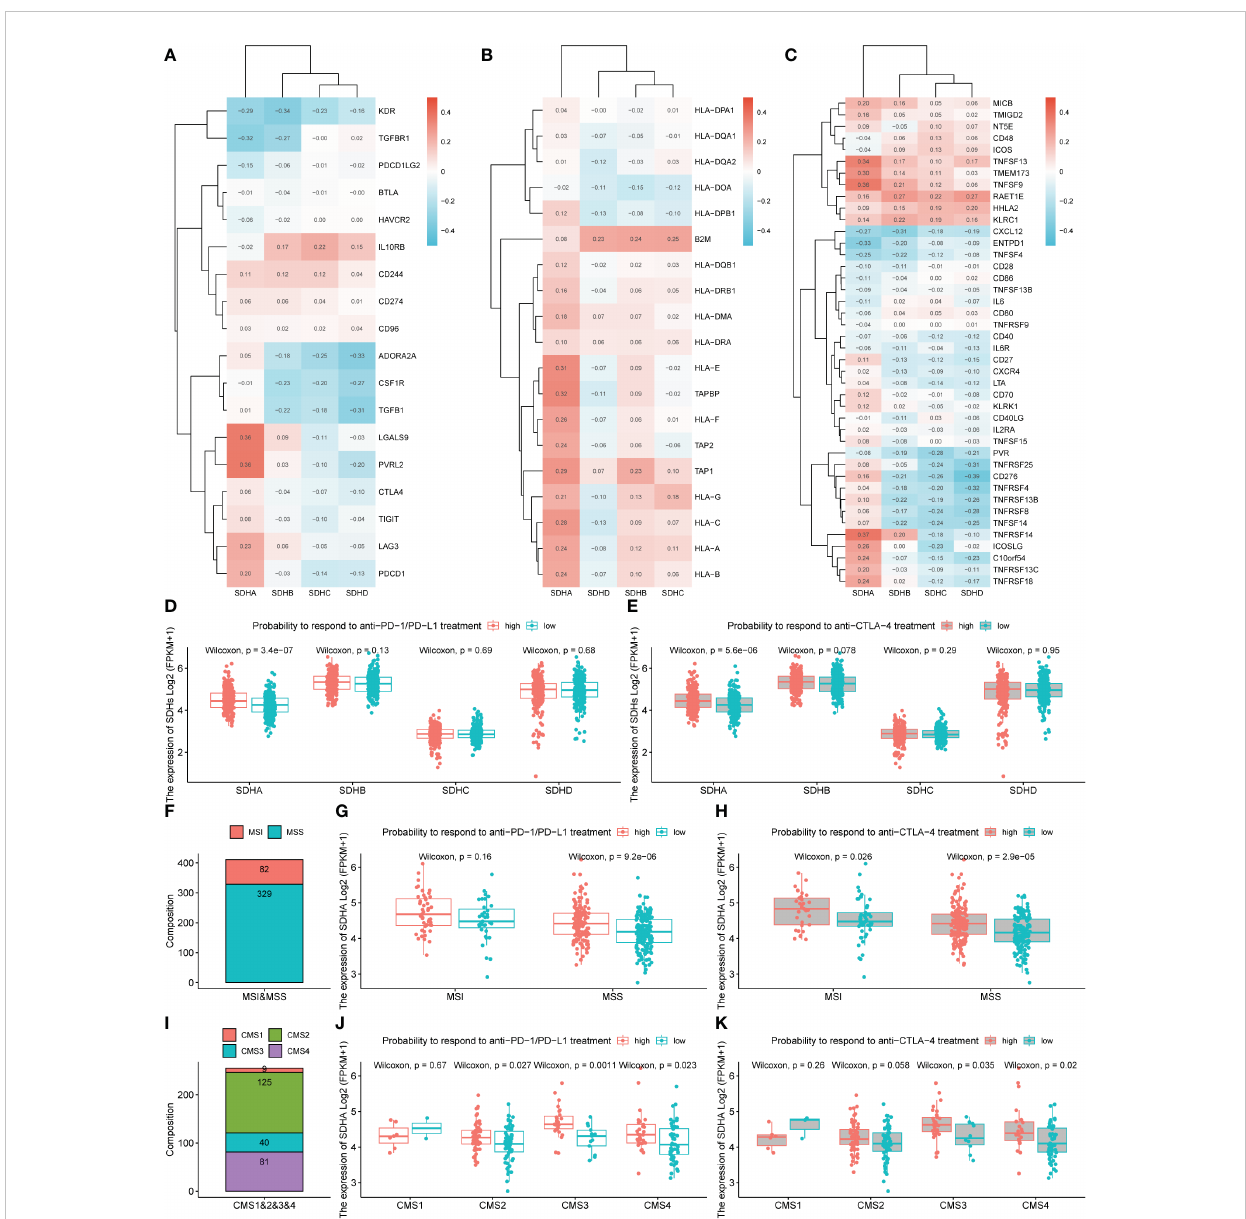
FIGURE 7 Immunotherapy outcomes prediction. (A-C) The correlation between SDHs and immunostimulatory, MHC, and immunosuppressive genes. (D, E) The association between SDHs expression and the relative probabilities of responding to immunotherapy, including anti-PD-1/PD-L1 therapy and anti-CTLA-4 therapy. (F) Proportions of MSI and MSS in patients. (G, H) The possibility to respond to immunotherapy based on different SDHA expression and MSI. (I) Proportions of CMS1, CMS2, CMS3, and CMS4 in patients in MSS. (J, K) The possibility to respond to immunotherapy in patients in MSS based on different SDHA expression and